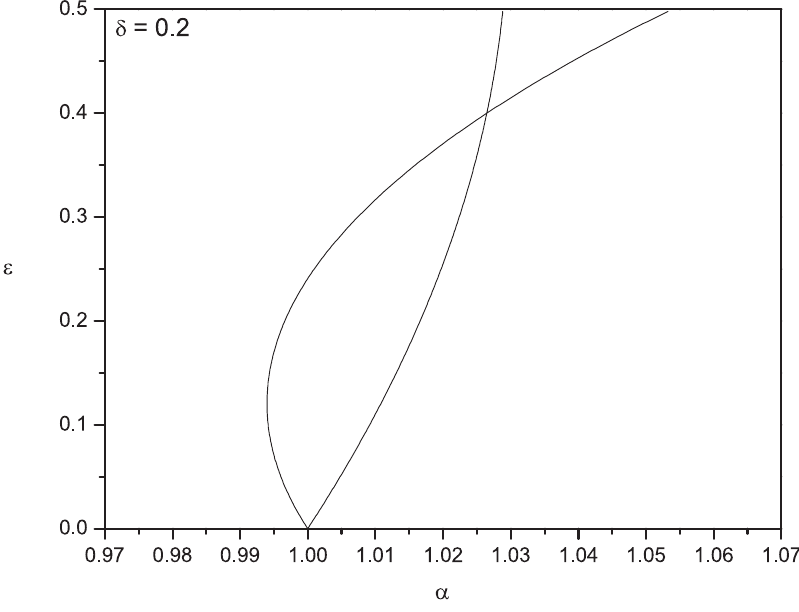
Figure 2. Analytical quadratic approximation boundaries of the stability regions for the tongue-tip at α = 1 and δ = 0 . 2 . The cross-over effect is